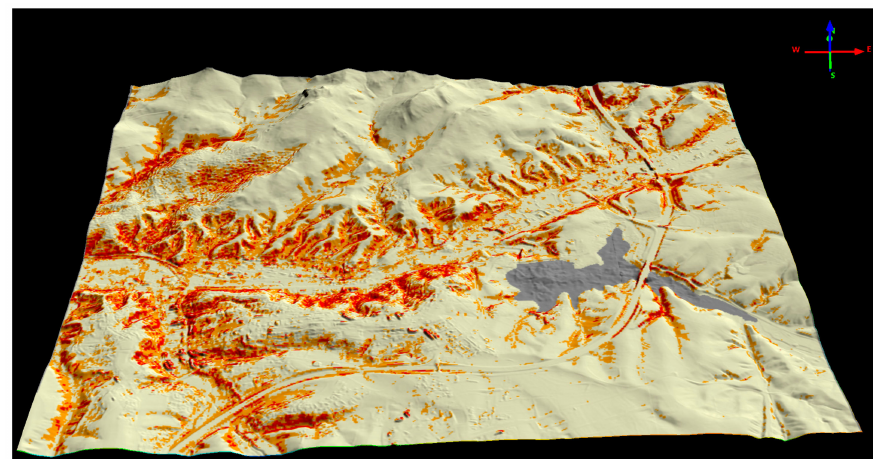
Figure 21. The DTM of the study area textured with the landslide susceptibility map (output of logistic